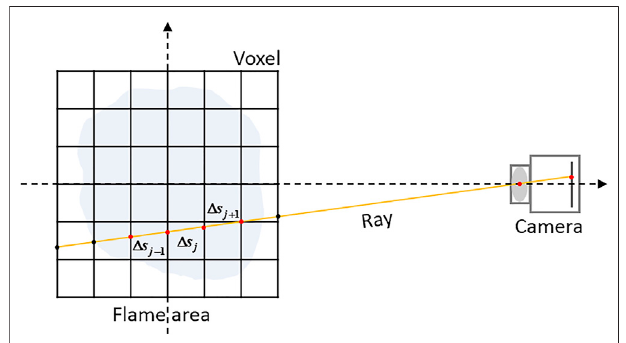
FIGURE 1 | The schematic diagram of fl ame radiation imaging for temperature